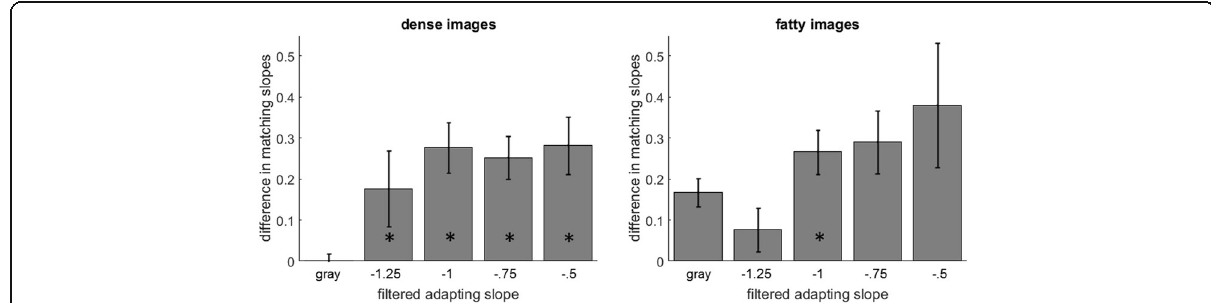
Fig. 4 Blur after-effects for the mammogram images (original vs sharpened) displayed in the left and right fields . Settings are shown for the dense images ( left ) or fatty images ( right ). Each bar shows the physical difference between the slopes of the test images in sharpened vs original adaptor field required to match the perceived slope of the two images and correspond to the mean settings ± 1 standard error. The * symbol indicates adapting slopes where the matching slopes were significantly different from the baseline (no adapt) condition